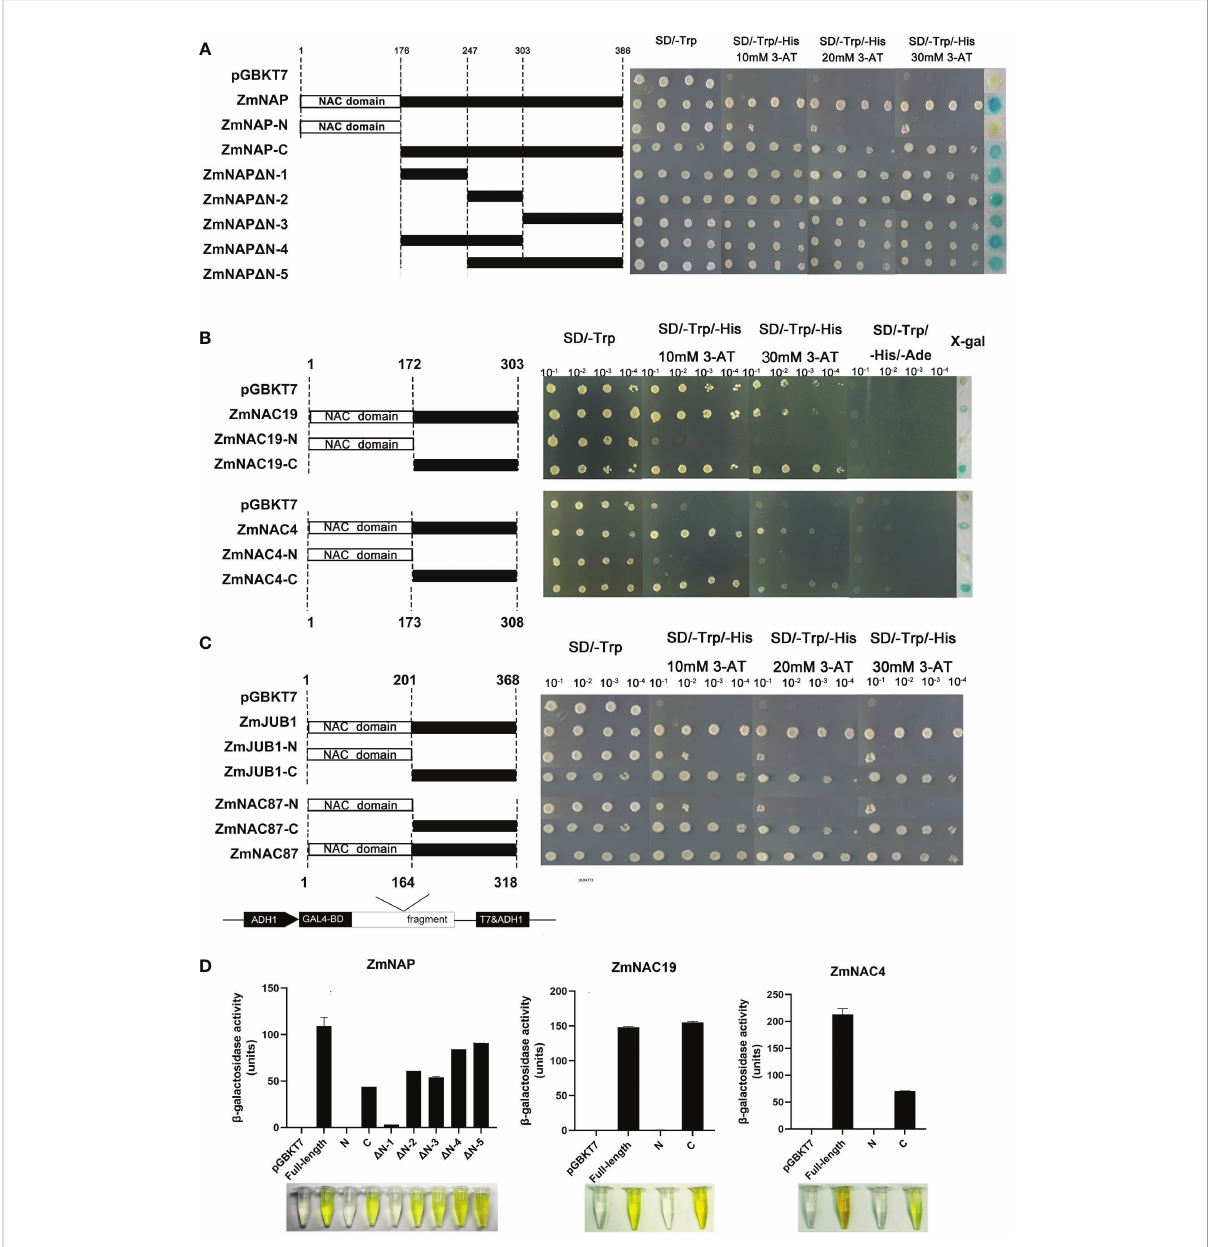
FIGURE 10 Transactivation analysis of the full-length CDSs and different truncations of ZmNAP, ZmNAC19, ZmNAC4, ZmJUB1, and ZmNAC87. (A) Transactivation activity analysis of the full-length CDSs and different truncations of ZmNAP. The Recombinant plasmids pGBKT7-ZmNAP-C, pGBKT7-ZmNAP-N, pGBKT7-ZmNAP D N-1, pGBKT7-ZmNAP D N-2, pGBKT7-ZmNAP D N-3, pGBKT7- ZmNAP D N-4, pGBKT7- ZmNAP D N-5 and prey plasmid pGBKT7 were transformed into the yeast strain AH109 and selected on the SD/-His/-Trp/3-AT medium. (B) Transactivation activity analysis of the full-length CDSs and different truncations of ZmNAC19 and ZmNAC4. The yeast transformation and screening methods are described above. (C) Transactivation activity analysis of the full-length CDSs and different truncations of ZmJUB1 and ZmNAC87. The yeast transformation and screening methods are described above. (D) b -galactosidase activity of ZmNAP , ZmNAC19 , and ZmNAC4 were determined in yeast strain Y187. The pGBKT7 vector was used as a negative